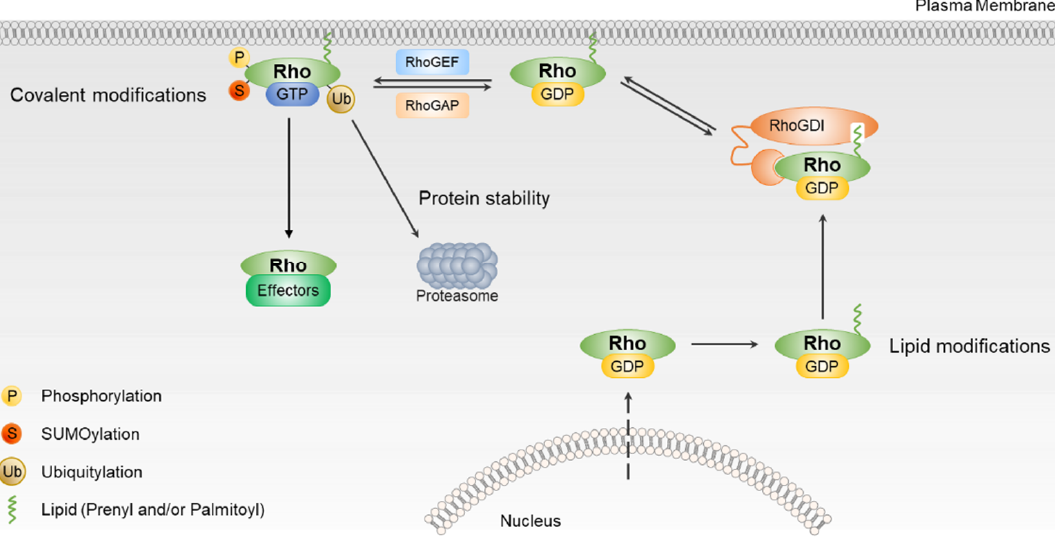
Figure 2. The regulation of Rho GTPases activation. Most Rho GTPases are regulated by RhoGEFs, RhoGAPs, and RhoGDIs. Rho GTPases are also regulated by post-translational modification, including phosphorylation, sumoylation, and ubiquitination. Post-translational modifications (PTMs) of Rho GTPases regulate their intracellular localization, stability, and ability to signal to downstream e ff